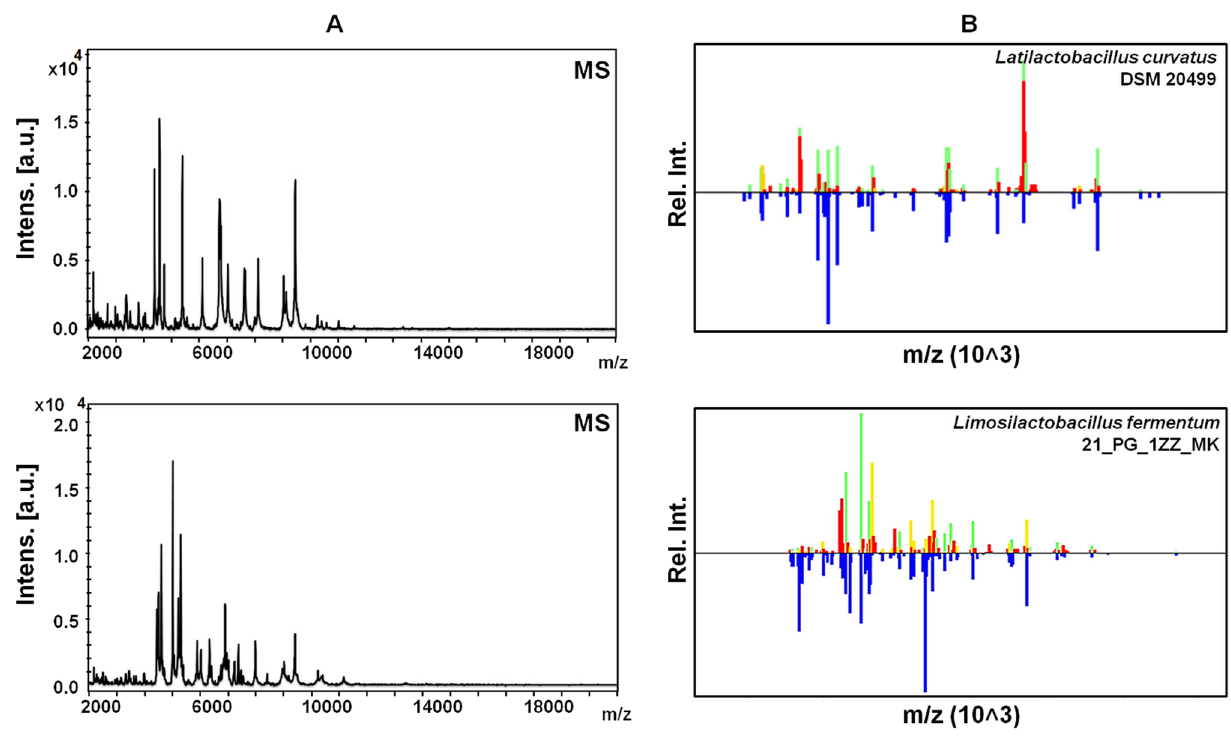
Fig. 2 MS ( A ) and MSP ( B ) spectrum showing picklist of the Latilactobacillus curvatus DSM 20,499 and Limosilactobacillus fermentum 21_ PG_1ZZ_MK reference strains identified by MALDI Biotyper Compass platform. Green color – signal of the sample match with reference specter in probability higher than 85%, yellow – signal of sample match with probability lower than 85%, red – no